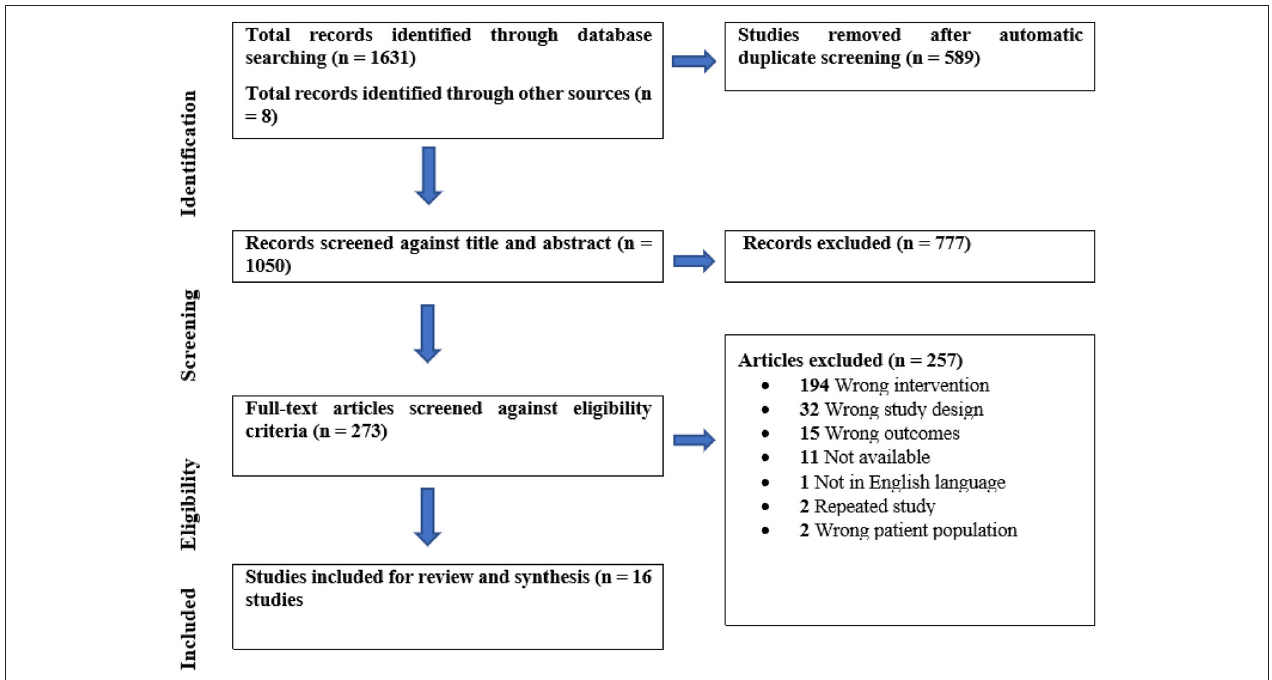
FIGURE 1 | PRISMA flowchart of study inclusion